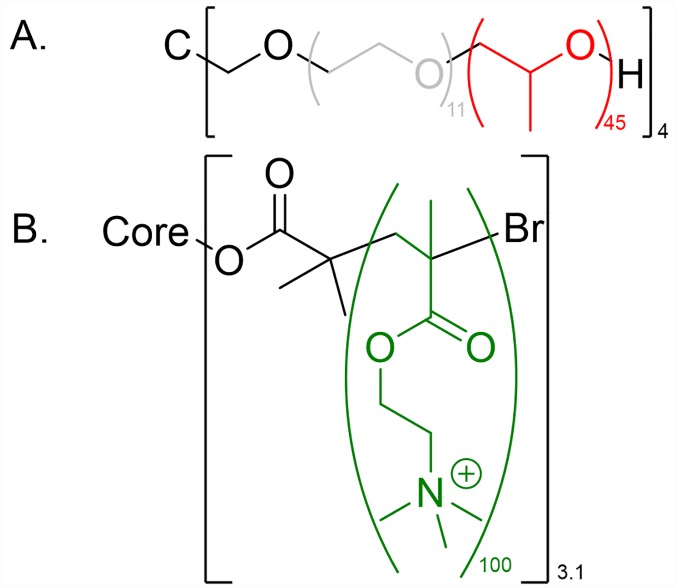
Chemical structures of polymers used.A. (PPO45-b-PEO12)4, B. (qPDMAEMA100)3.1 with glucose core (red: PPO polymer segments interacting with interior liposome membrane; grey: hydrophilic “non-interacting” PEO segments; green: polymer segments interacting with the exterior liposome membrane (charged lipids).